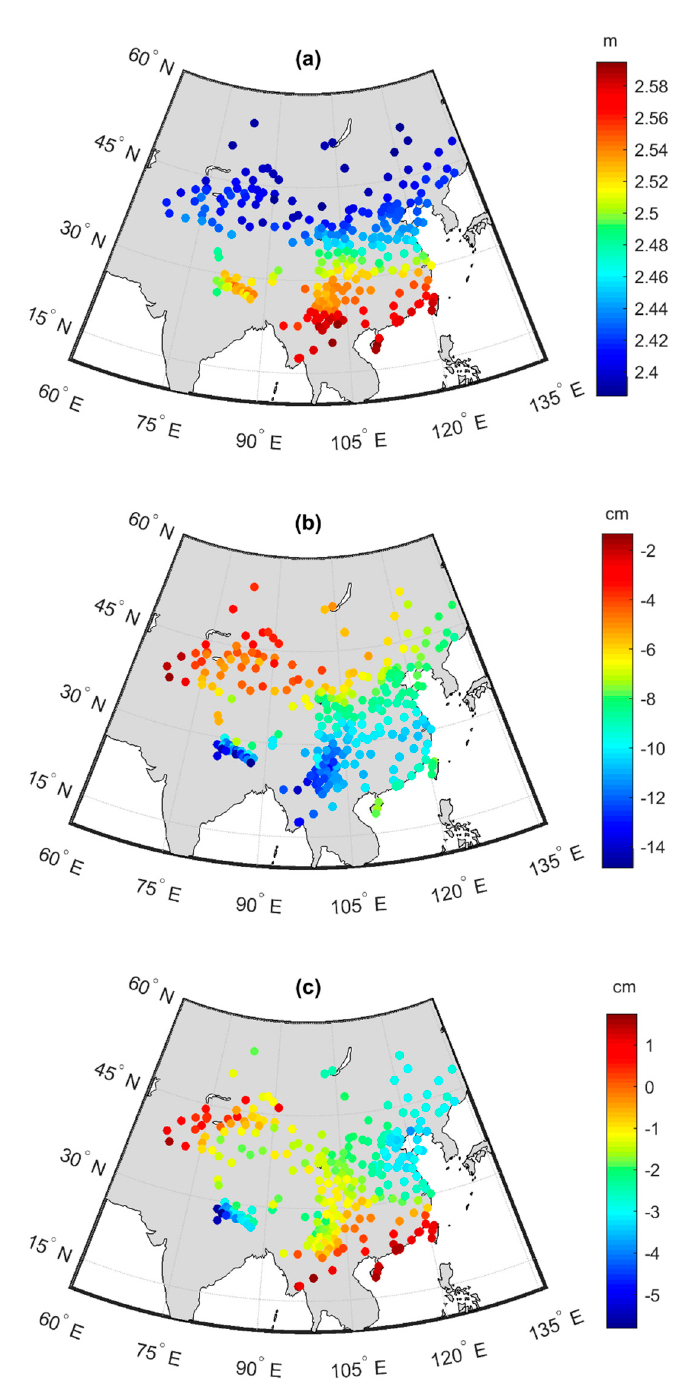
Figure 5. ( a ) The constant term A 0, e , ( b ) the annual amplitude term A 1, e , and ( c ) the semi-annual term A 2, e of ZTD scaled on the ellipsoid of each A 2, e of ZTD scaled on the ellipsoid of each site.